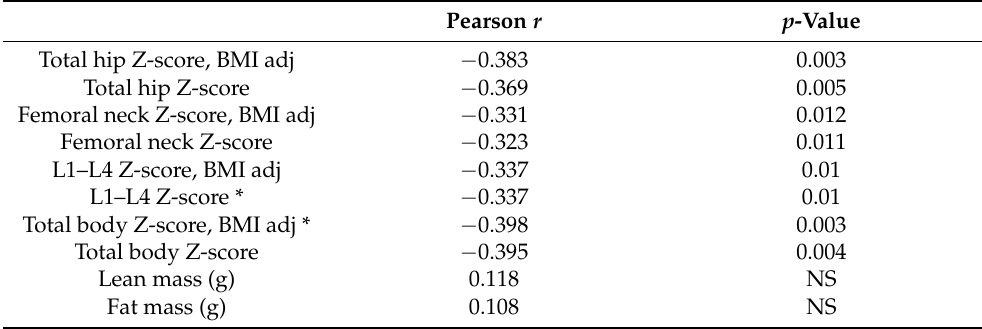
Figure 1. Correlation observed between ZIC1 promotor methylation and ZIC1 expression. ( A ) Corre- lation between ZIC1 promotor methylation in CpG1 and ZIC1 expression in the male lumbar spine trabecular bone (Pearson r = − 0.79, p = 2.4 × 10 − 6 ) (Table 1). ( B ) ZIC1 expression in the iliac bone of postmenopausal women showed a significant negative correlation with BMD. An inverse association between ZIC1 expression and total femoral BMD Z-score that had been adjusted for variation in body mass index (BMI) ( r = − 0.383; p = 0.0033) was observed. ( C ) A difference was observed in the methylation levels of ZIC1 promoter at CpG1 from iliac (IB) and lumbar regions (L3–L5) (expressed as %), skeletal sites of low and high mechanical stress, respectively. Table 2. Correlation between ZIC1 expression level in iliac bone of postmenopausal women with BMD, lean body and fat mass ( n =